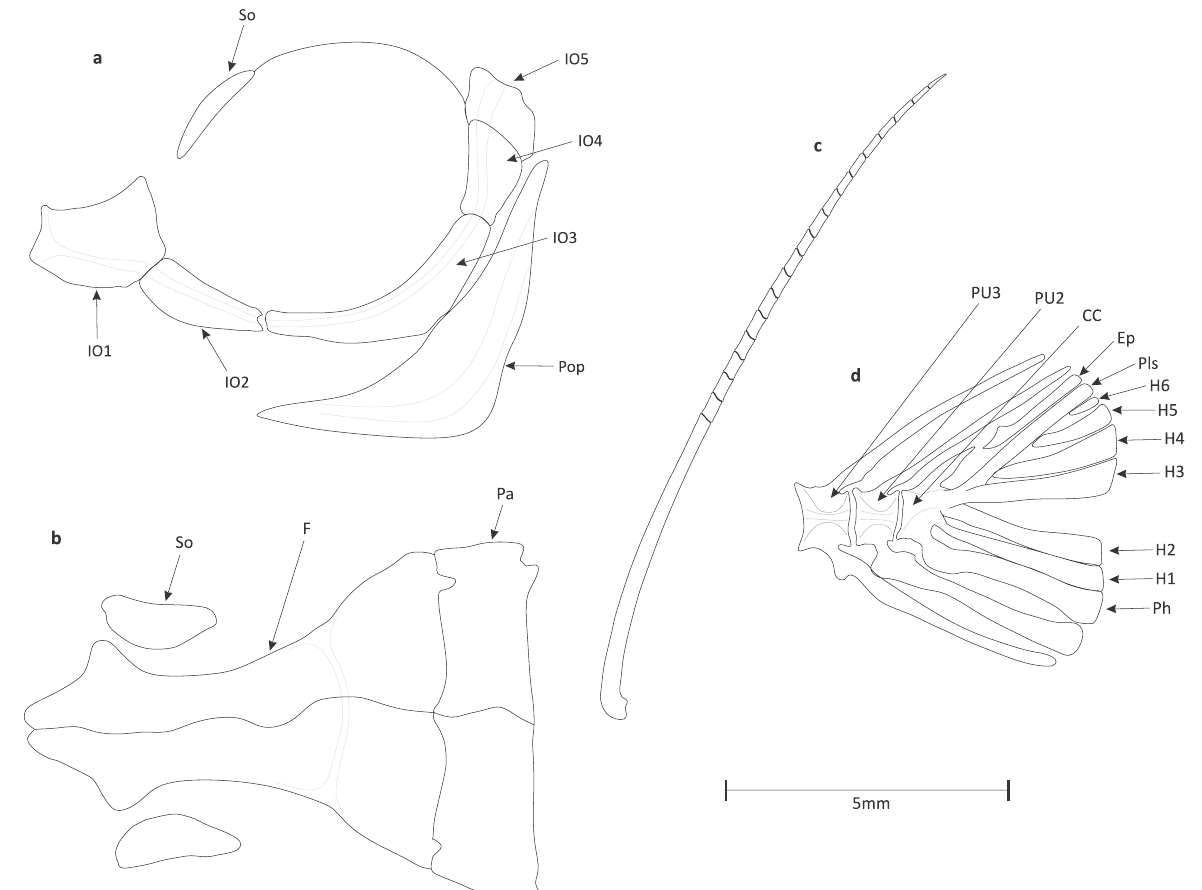
Figure 1. Sahyadria denisonii , (CRG-SAC 2009.21.7), 51.0mm SL. (a) Circumorbital series (IO1-5, infraorbitals; So, supraorbital; Pop, preopercle); (b) dorsal view of orbital region of cranium (F, frontal; Pa, parietal); (c) last unbranched dorsal-fin ray; and (d) caudal skeleton (CC, compound centrum; Ep, epural; H1-6, hypurals 1-6; 1-5; ; Ph, parhypural; Pls, pleurostyle; PU2, PU3, preural centra 2, 3). Note that the supraorbital sensory canal is not